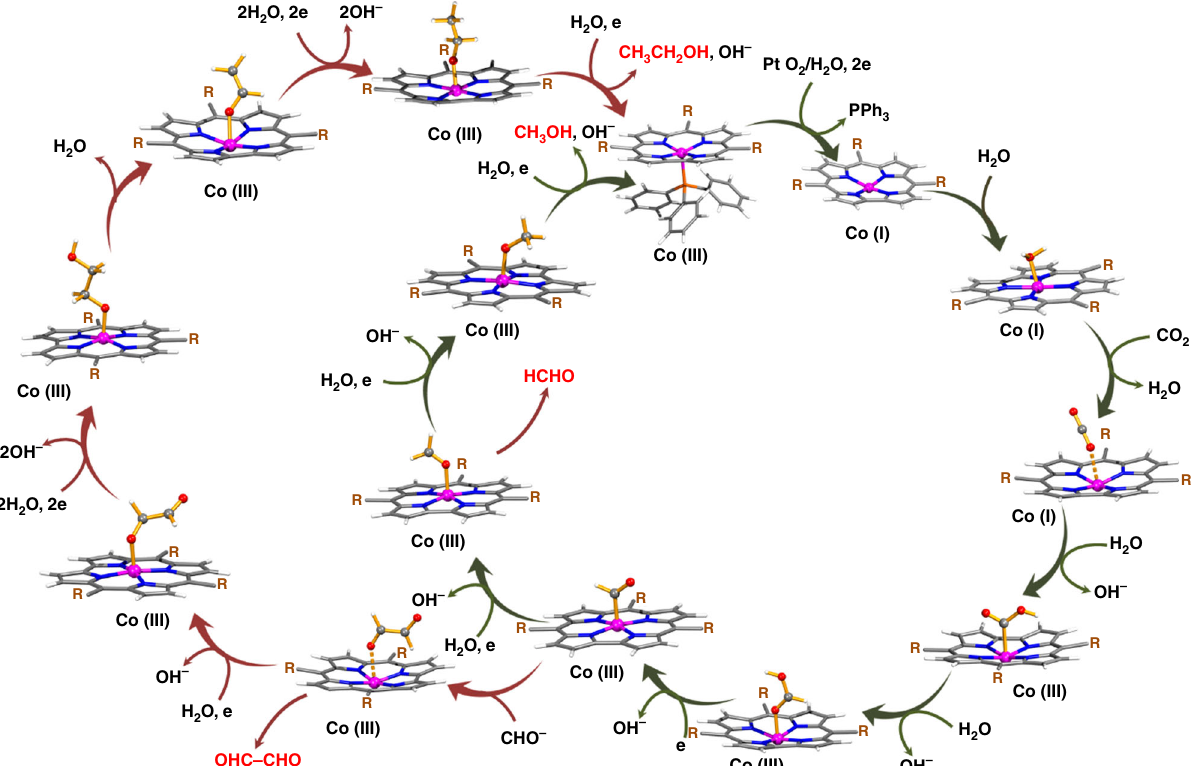
Fig. 4 Proposed single site mechanism of CO 2 reduction using